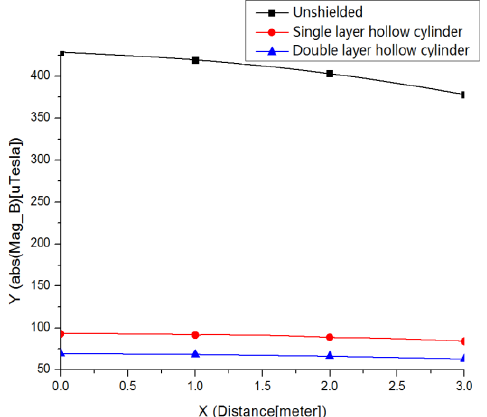
Figure 13. Shielding effect of different positions.